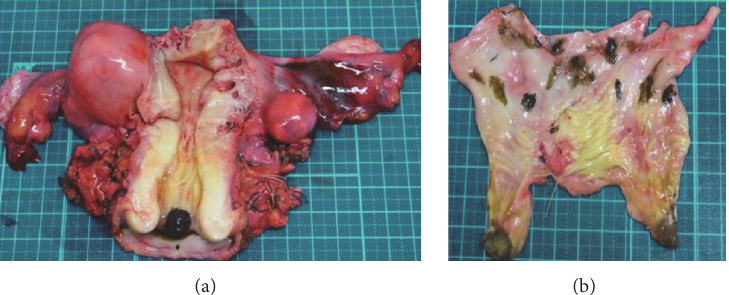
Figure 2: Surgical specimens showed a 2 cm polypoid blackish-pigmented tumor in the uterine cervix (a), and multiple small blackish- pigmented tumors throughout the vaginal wall